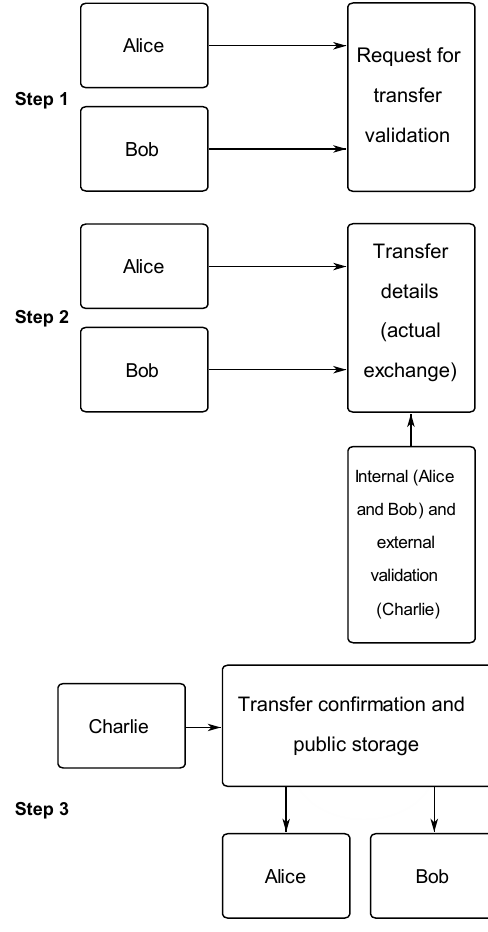
Figure 1. The proposed transfer scheme between Alice and Bob, for the scenario of a single validator (Charlie). Step 1. Alice and Bob announce their exchange intent, thus requiring an entity to validate the transfer. Step 2. The transfer details are mapped in a quantum circuit, together with the internal and external validation processes. Step 3. If everything is in order, the validator entity confirms the transfer details, merging the details into the public ledger.